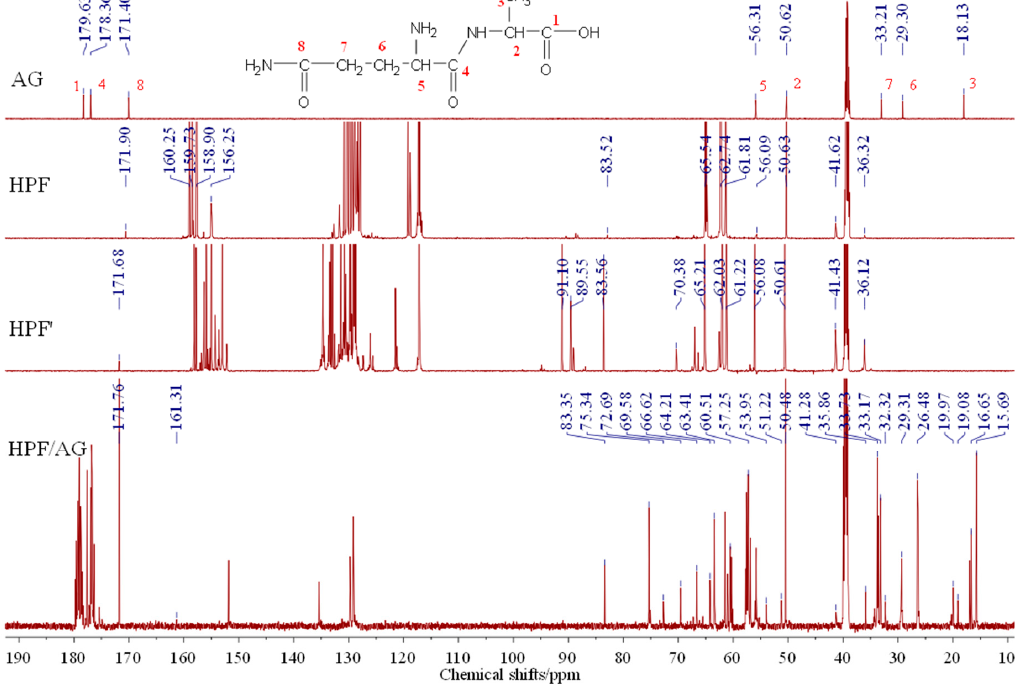
Figure 6. 13 C-NMR spectra of sample AG, HPF, HPF’ and HPF/AG.